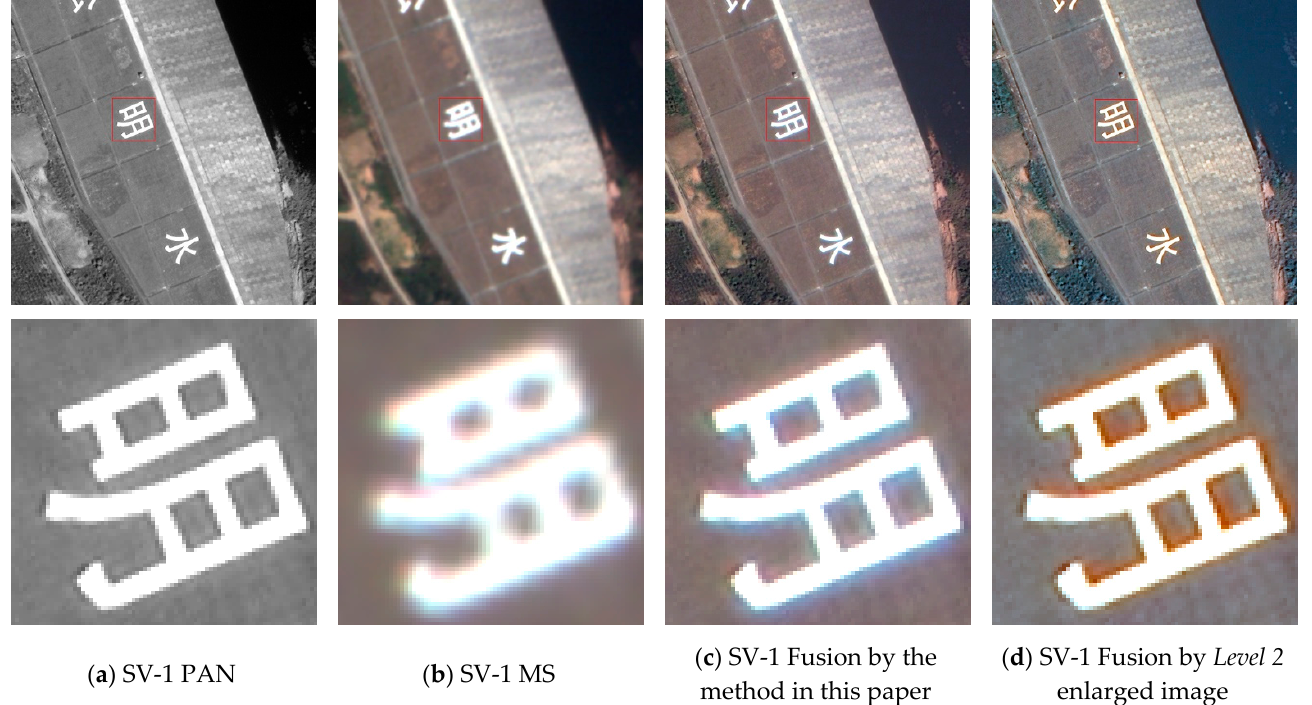
Figure 9. Comparison of the SV-1 fusion image created using the method in this paper and the fusion image created using the Level 2 PAN and MS enlarged image. ( a ) PAN image; ( b ) enlarged MS image; ( c ) fusion image created using the method in this paper; ( d ) fusion image created using the enlarged Level 2 image.